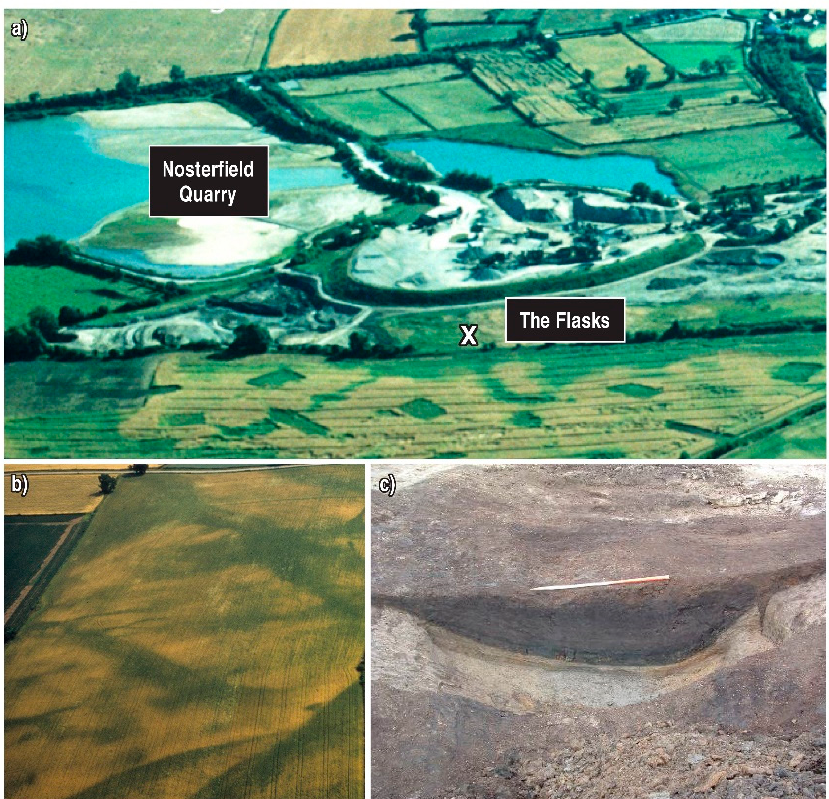
Figure 5. ( a ) Aerial photgraph (2003) of Nosterfield Quarry, looking south, by Wishart Mitchell. The location of the Flasks 69 profile is marked with an X. ( b ) Aerial photograph of palaeochannels visible in the Nosterfield outwash fan (Dr. Peter Addyman). ( c ) Example of the sediment fill of one of the Nosterfield palaeochannels, showing a tripartite sequence (Mike Griffiths Associates). For location of Nosterfield Quarry, see Figure 1.